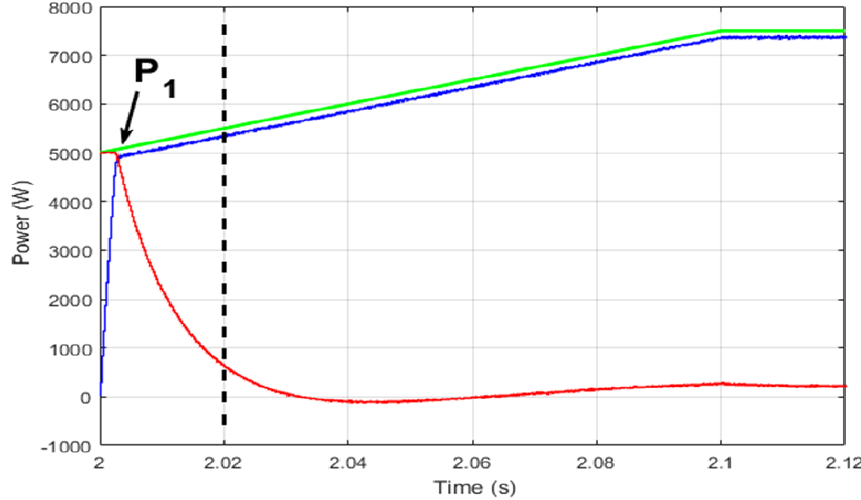
Figure 17. Classical abrupt power source switching.